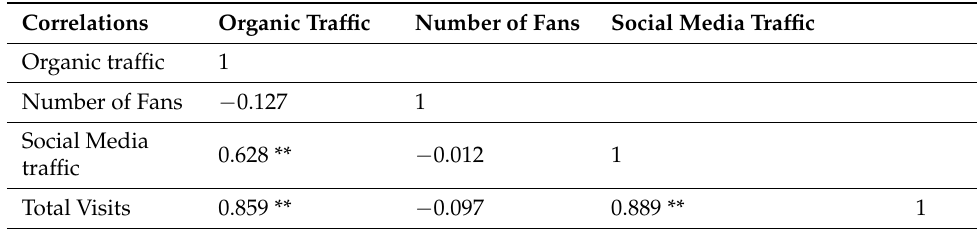
Table 8. Coefficients between the examined metrics for H4.